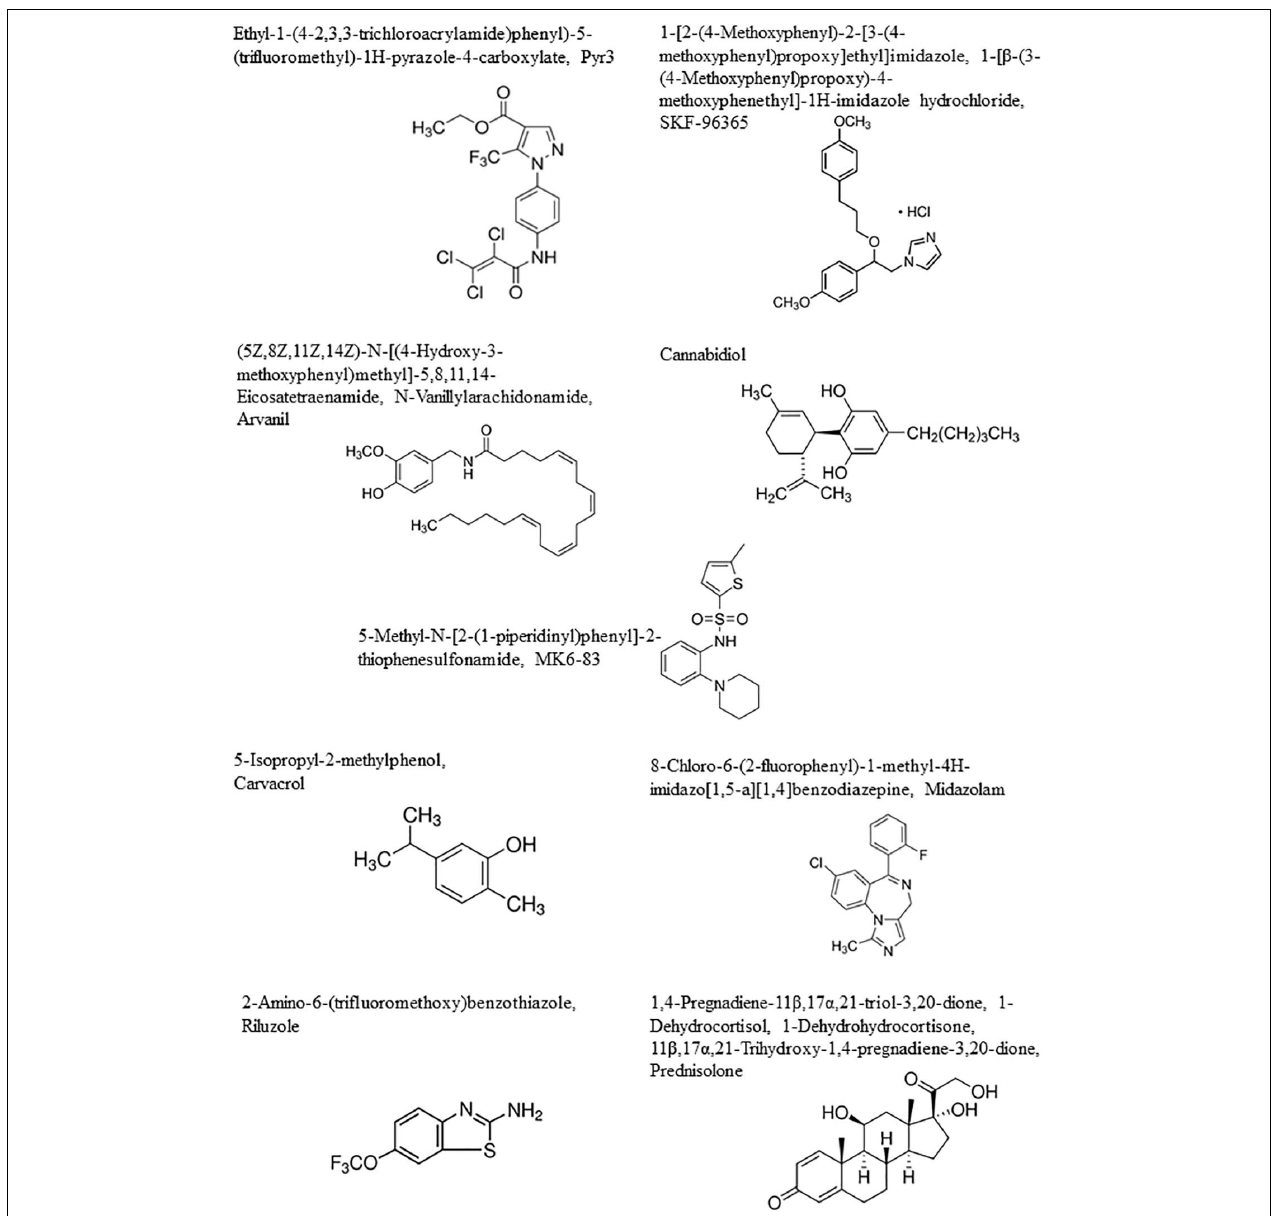
FIGURE 2 | Chemical